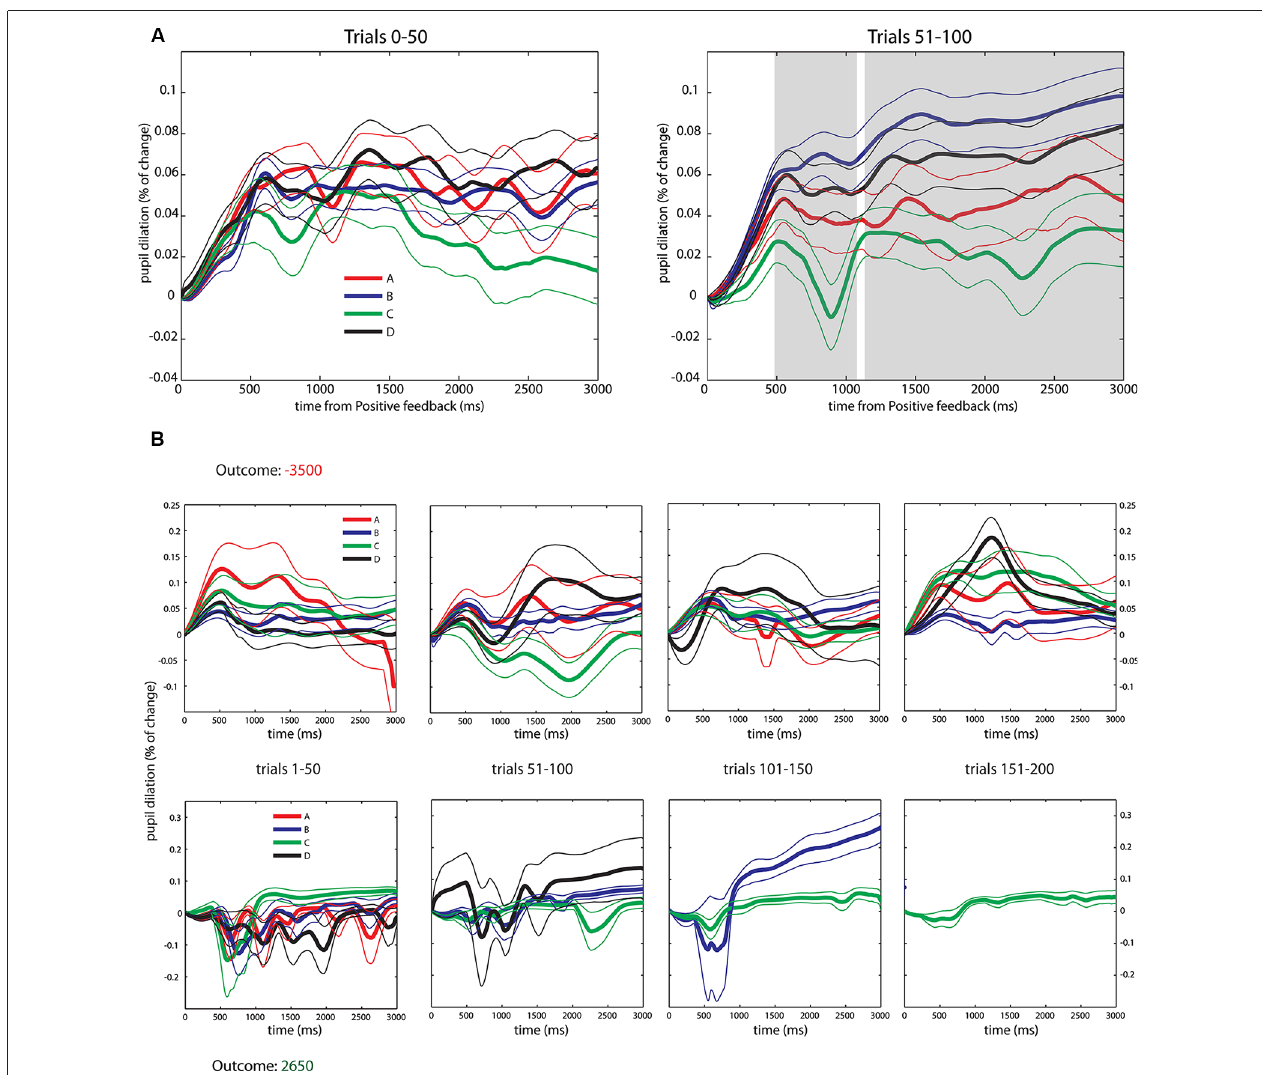
identical as the applied to pooled data. Significant results are reported after FDR correction, p FDR < 0.05. (B) Pupil dilation dynamics during PF across the whole duration of the IGT for two subjects with extreme performances, data organized in four bins of 50 trials. Top : Subject with worst outcome. Bottom : Subject with best outcome. All data depicted as Mean + / −